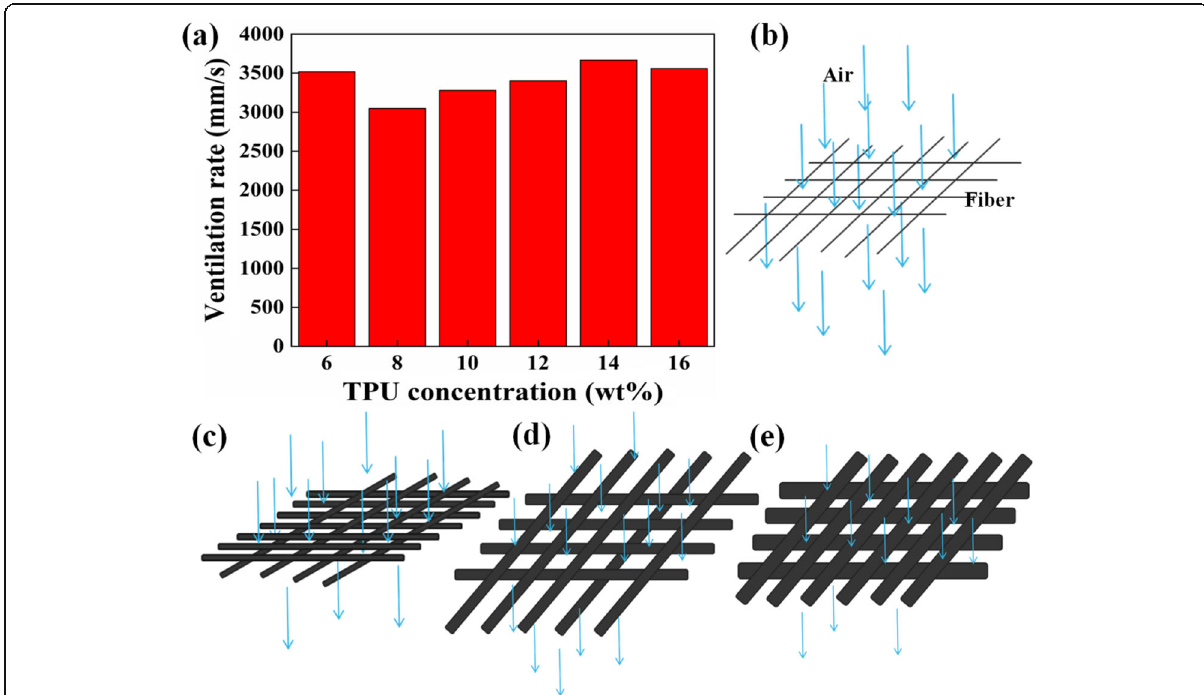
Fig. 5 Ventilation rate evaluation of TPU fiber membrane. a Ventilation rate of different concentrations of TPU fiber membranes. b – e Air passes through fibers of different